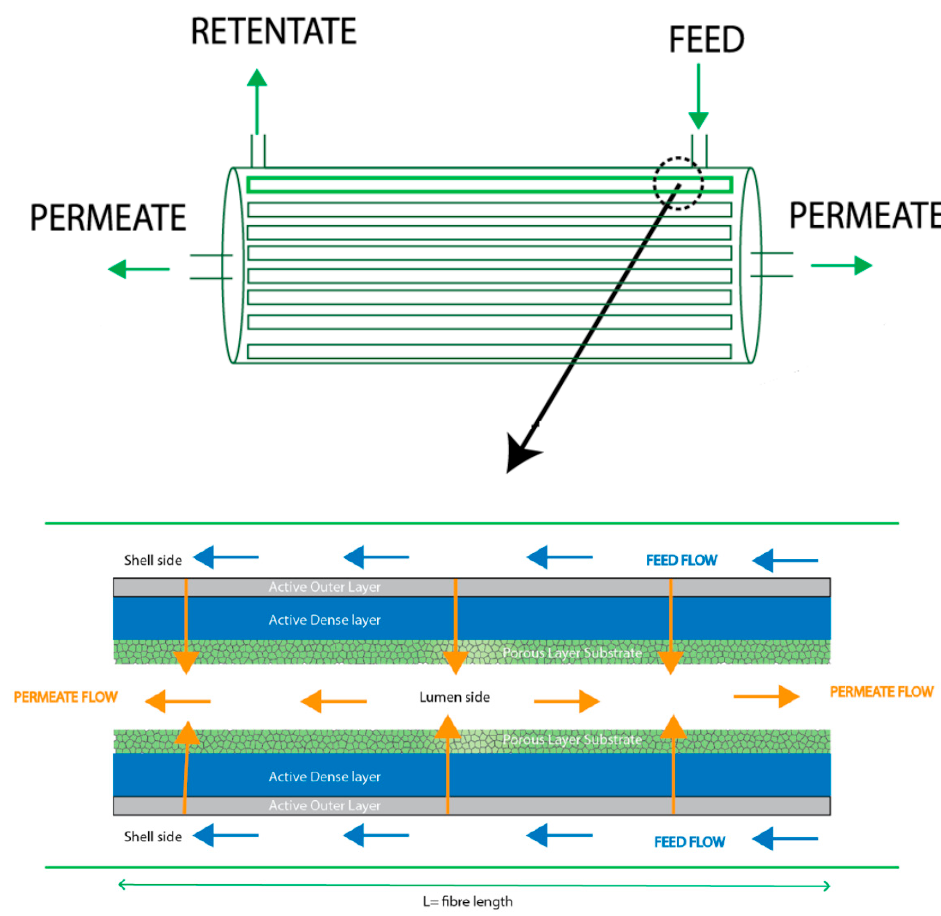
Figure 1. Pervaporation module.